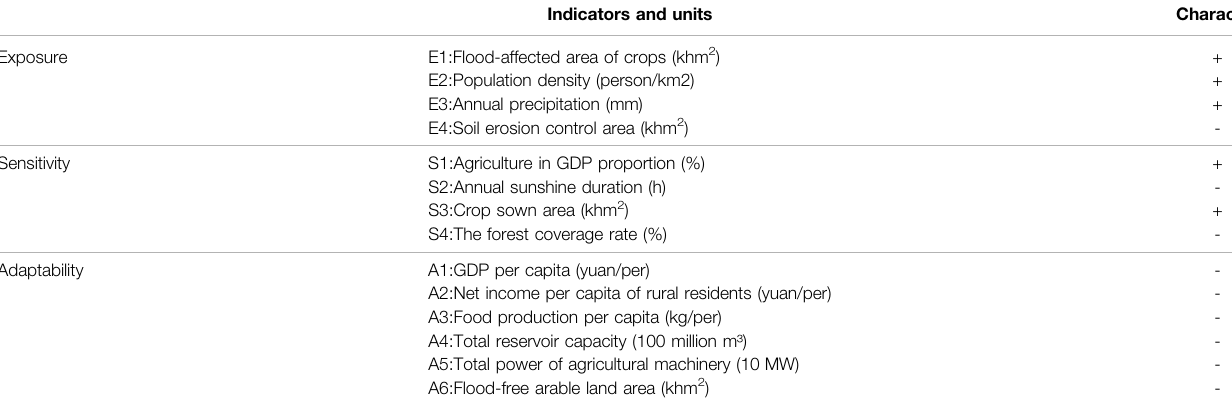
TABLE 1 | China ’ s agricultural fl ood vulnerability evaluation index system.